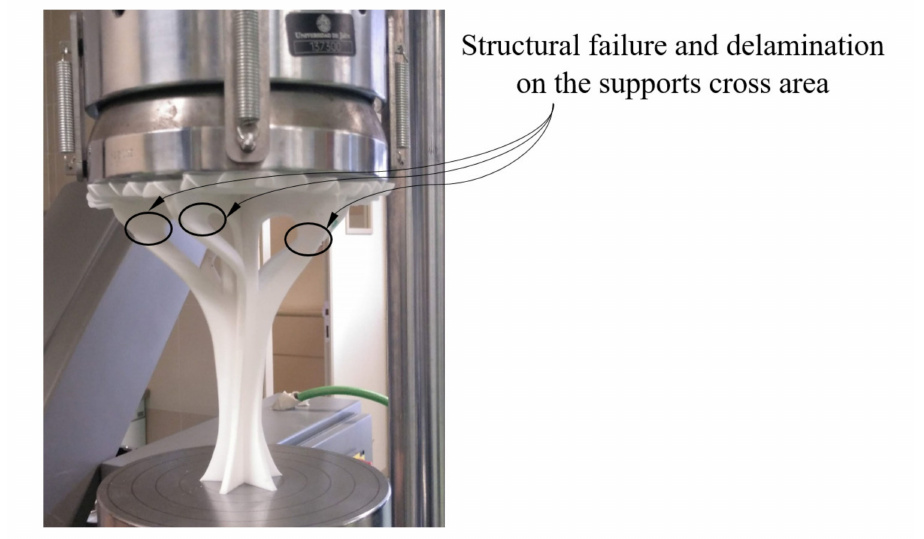
Figure 12. Fracture of the Z-axis printed element under